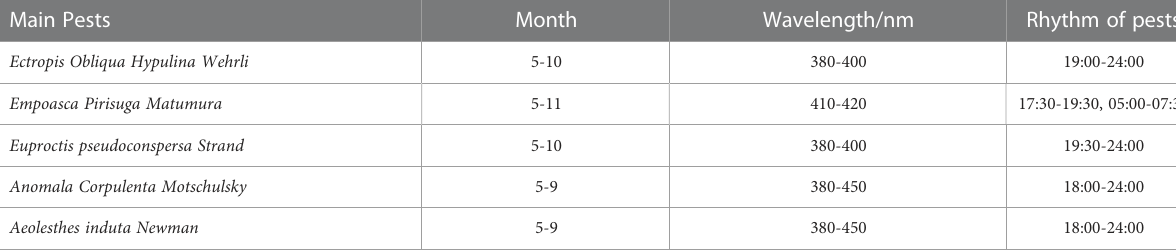
TABLE 5 Effect of wavelength on the phototactic rhythm of main pests in tea garden. Main Pests Month Rhythm of pests Ectropis Obliqua Hypulina Wehrli